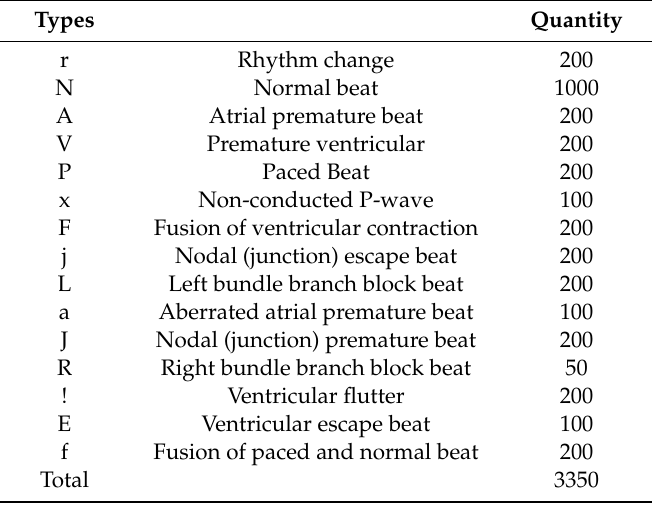
Table 8. The details of the categories on MIT-BIH